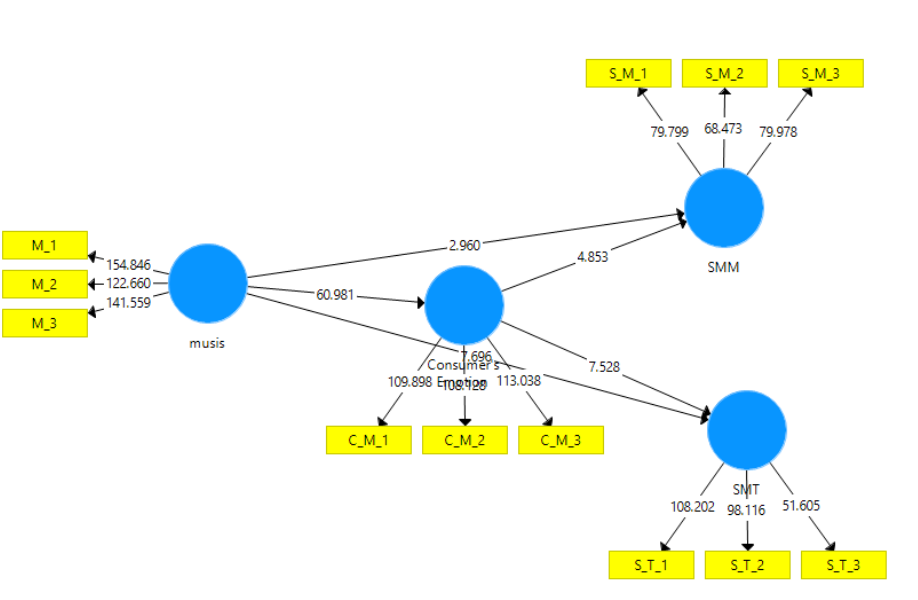
Figure 2: Assessment of Measurement